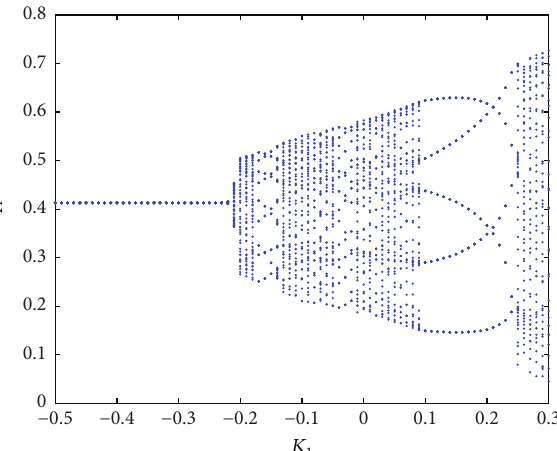
Figure 5: Bifurcation diagram with respect to parameter 𝐾 1 against variable 𝑞 1 with 500 iterations of map (19) for V 1 = 0.85, V 2 = 0.7, 𝑐 1 = = 2 . 0.2, 𝑐 2